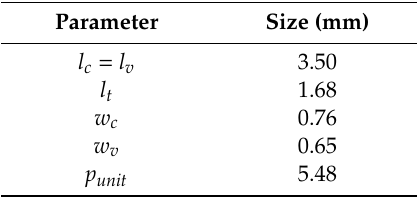
Figure 2. Geometry of the modified BAA unit-cell with vertical bowtie and horizontal semi-circular segments printed on a 0.254 mm thick grounded Arlon DiClad 880. Table 1. Table of parameters of